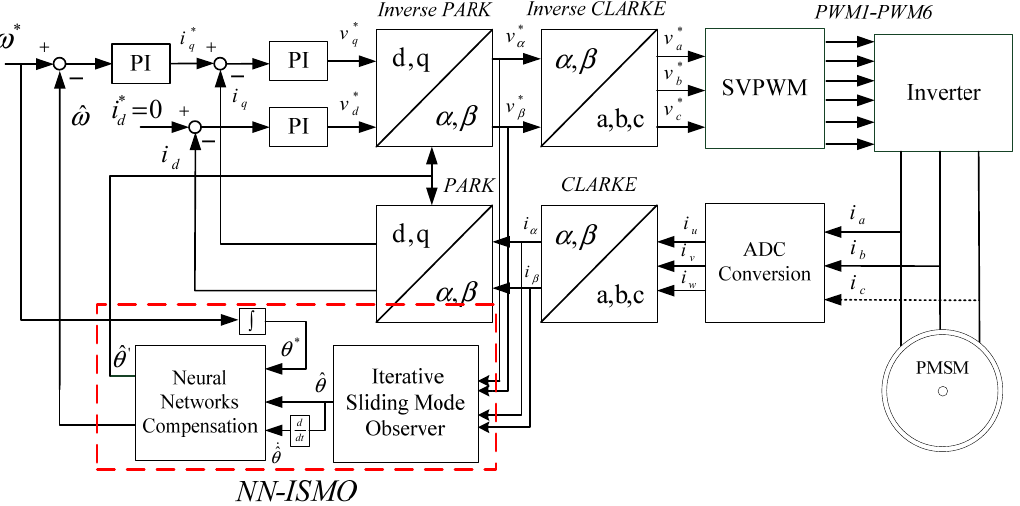
Figure 1. The block diagram of the proposed sensorless permanent magnet synchronous motor (PMSM) control system.